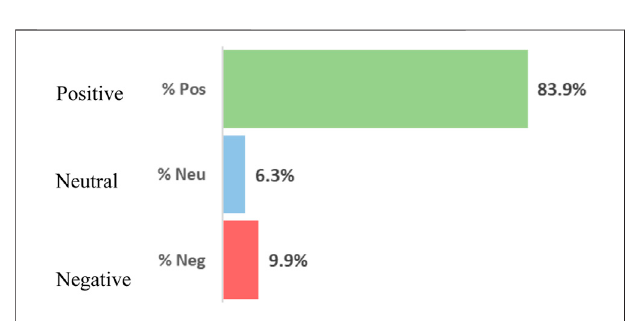
FIGURE12| Negativesentiment(Note:darkredandlightredareusedin the chart to identify every negative word or phrase).